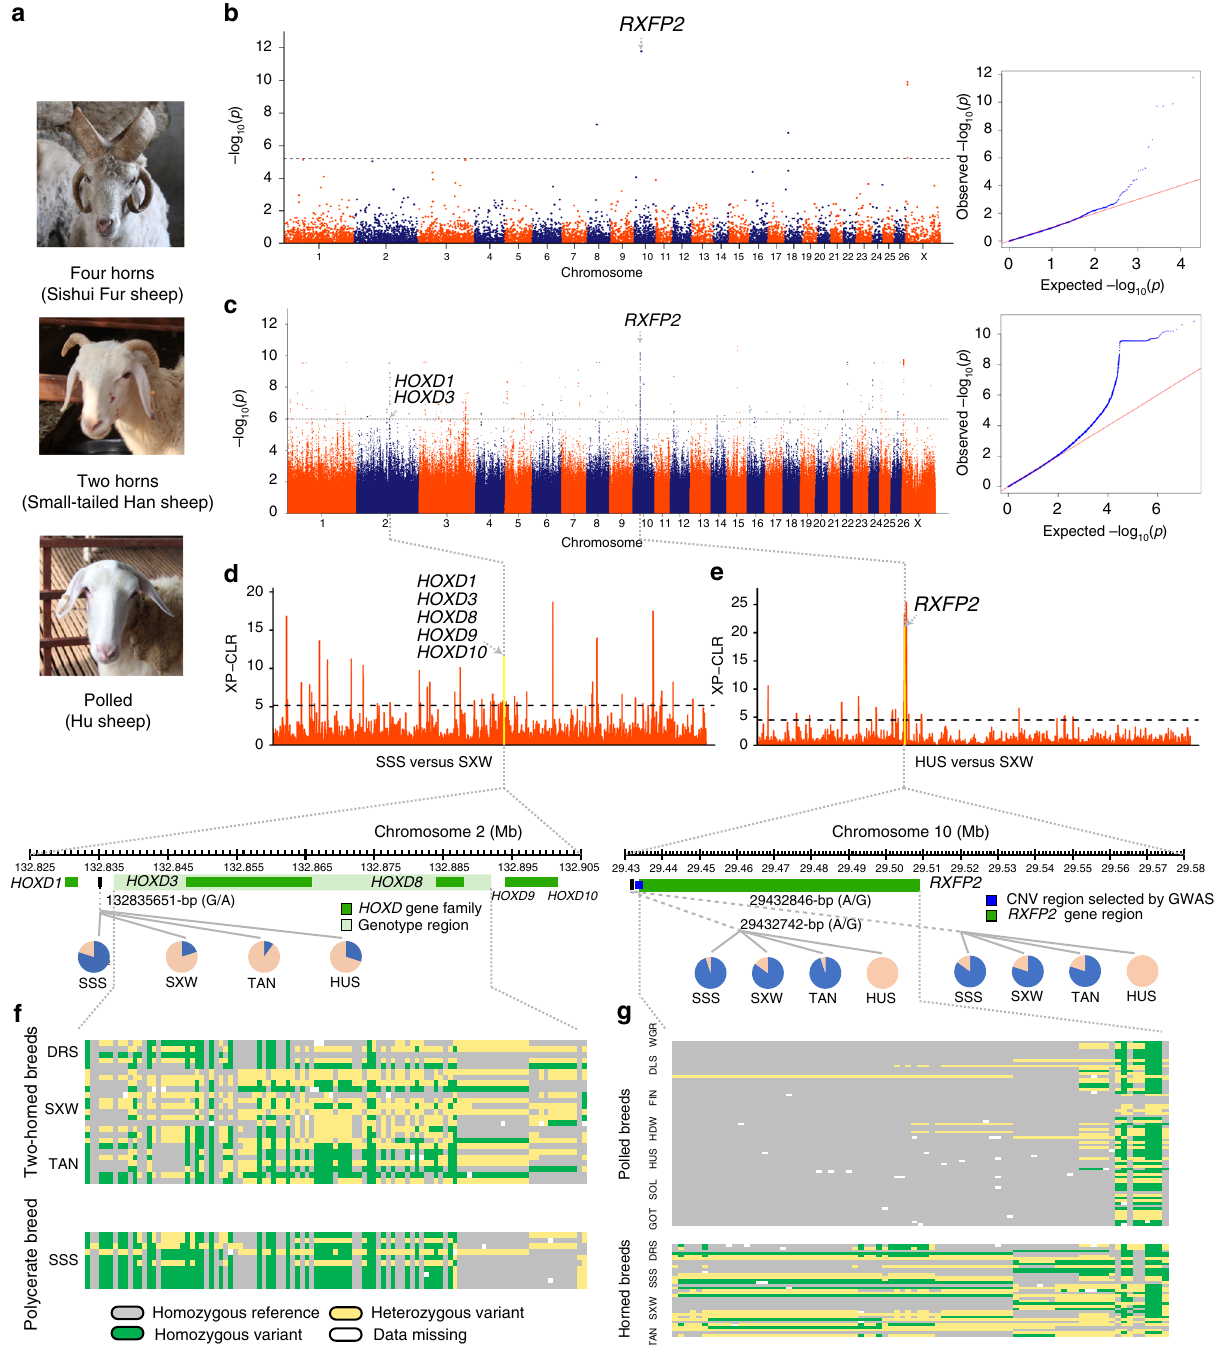
Fig. 5 Selective and association signatures for sheep horn number. a Different phenotypes of horn types between Sishui Fur sheep (SSS), Small-tailed Han sheep (SXW), and Hu sheep (HUS); picture credit: Meng-Hua Li. b , c Manhattan plot and quantile – quantile plot of association signals for the number of horns based on whole-genome CNV data b and SNPs c . The horizontal dashed lines correspond to the genome-wide signi fi cance thresholds ( − log 10 (0.05/Total CNVs) = 5.29 for CNVs and − log 10 ( P value) = 6 for SNPs). d Manhattan plot of selective sweeps for polycerate trait (SSS versus SXW) on chromosome 2. Allele frequency distribution of one non-synonymous SNP at the downstream of HOXD1 gene in one polycerate breed (SSS), two two-horned breeds (SXW and TAN) and one polled breed (HUS). The horizontal dashed line corresponds to the genome-wide signi fi cance threshold (XP- CLR = 5.17). e Manhattan plot of selective sweeps for polled trait (HUS versus SXW) on chromosome 10. Allele frequency distribution of one non- synonymous SNP at the downstream of RXFP2 gene in one polycerate breed (SSS), two two-horned breeds (SXW and TAN) and one polled breed (HUS). The horizontal dashed line corresponds to the genome-wide signi fi cance threshold (XP-CLR = 4.49). In all pie chart fi gures, the variant allele is indicated in blue, whereas the reference allele is indicated in pink. f Genotype patterns of the genes HOXD3 and HOXD8 among one polycerate breed and three two- horned breeds. g Genotype patterns of the gene RXFP2 among four horned breeds and seven polled breeds. Source data are provided as a Source Data fi